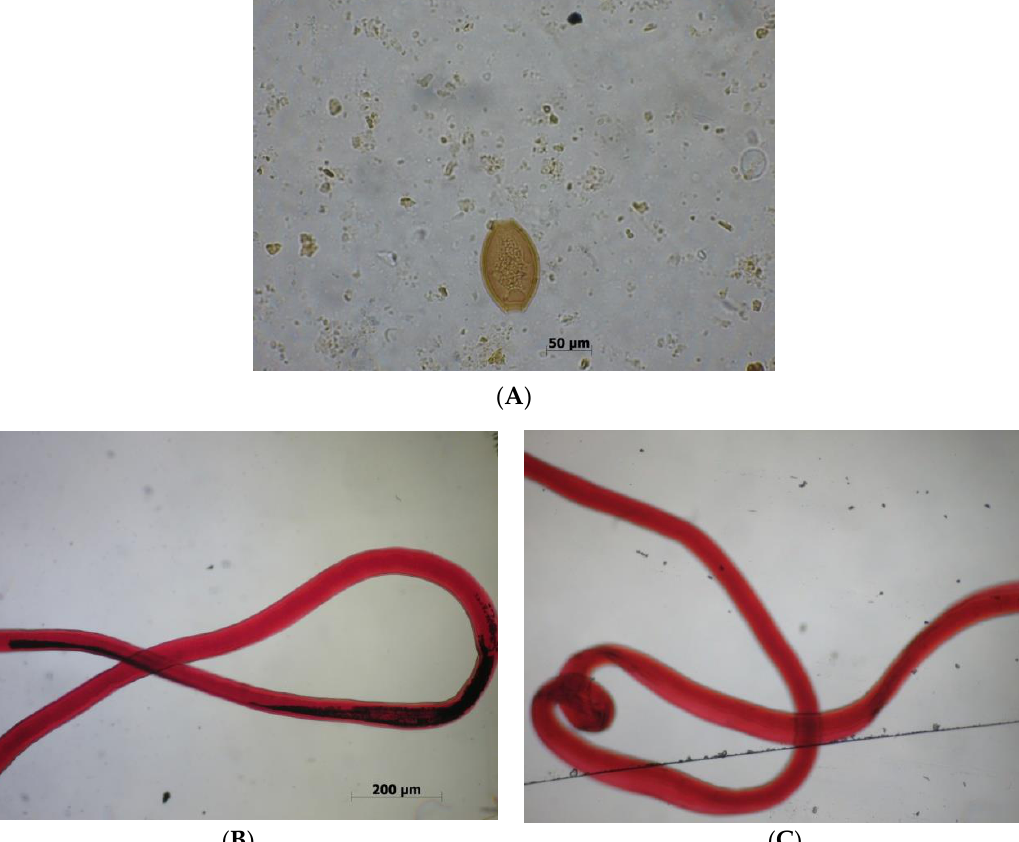
Figure 7. ( A ) Egg of T. trichiura in an iodine-stained wet mount at 40x. ( B ) Adult of T. trichiura at 4x ( C ) Adult of T. trichiura at 4x (all original photography).